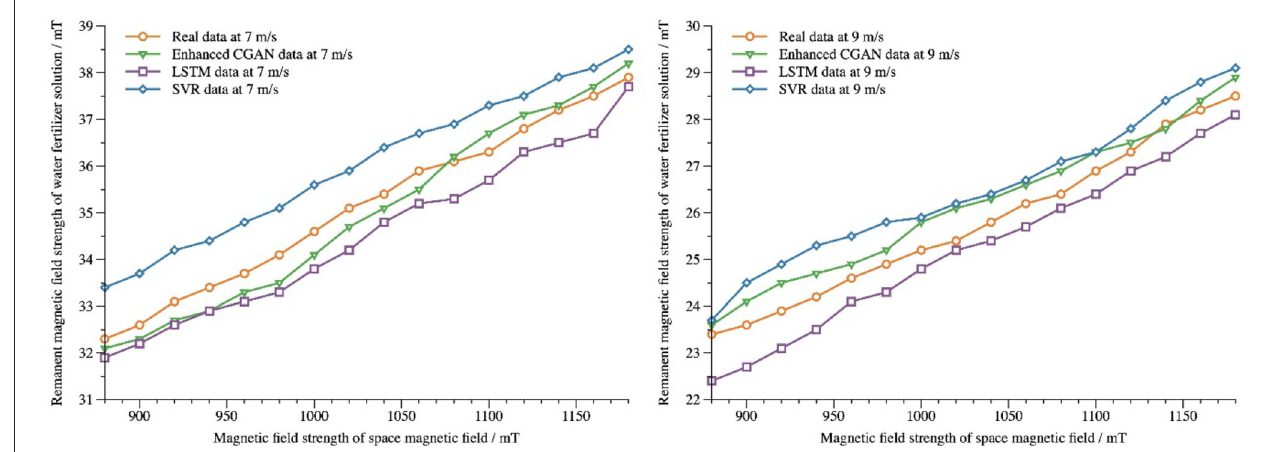
FIGURE 8 | Comparison of prediction results of different prediction models.